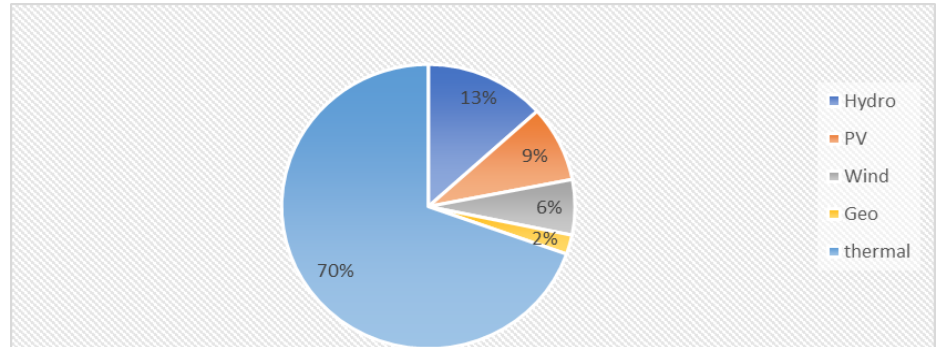
Figure 8. Exergy outputs of the Italian CO sector according to production technology. Hydro and thermal cycles (Rankine and Brayton cycles) still lead the sector (2017).